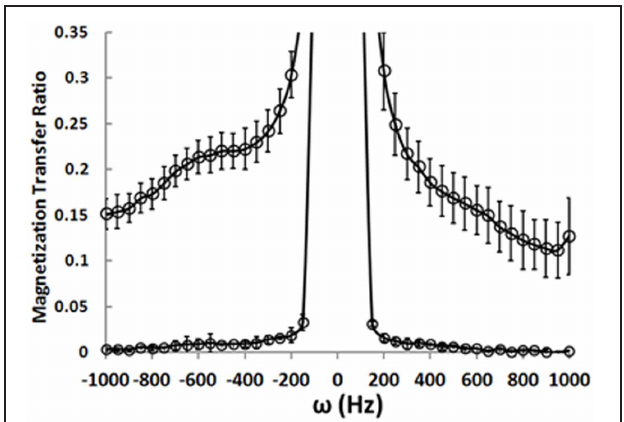
FIGURE 4 | Magnetization transfer ratio